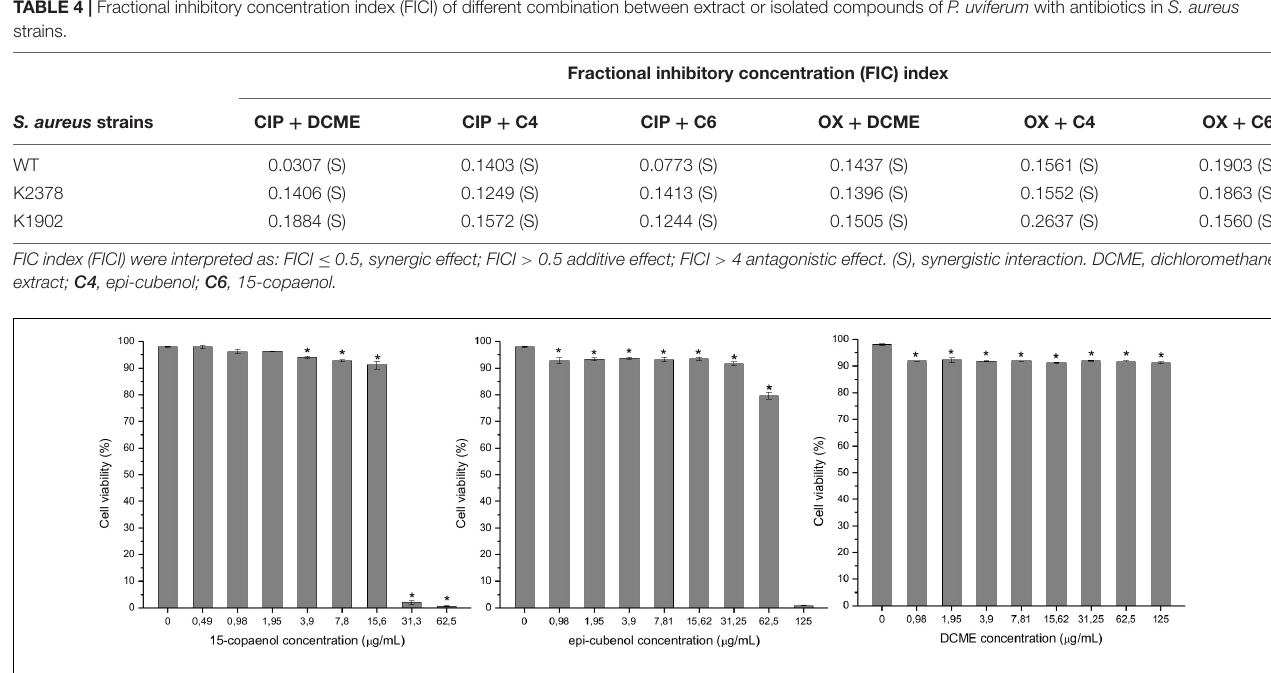
TABLE 4 | Fractional inhibitory concentration index (FICI) of different combination between extract or isolated compounds of P. uviferum with antibiotics in S. aureus strains.